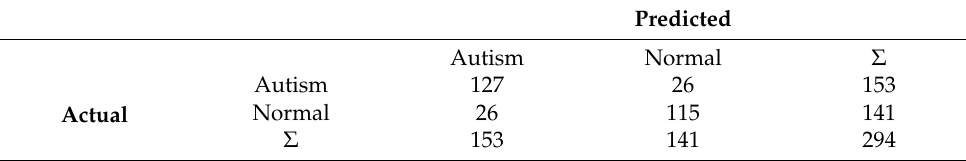
Table 7. Confusion matrix from Exp-1 (model trained and tested with the Kaggle dataset).